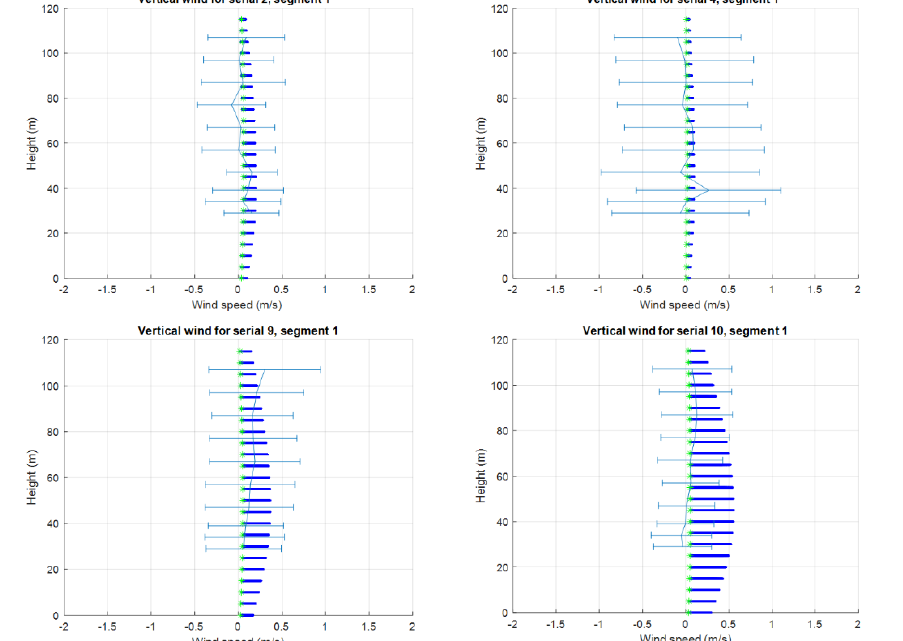
Figure 2: Comparison between vertical wind speed components observed by LIDAR (light blue) and UAV-based AAT